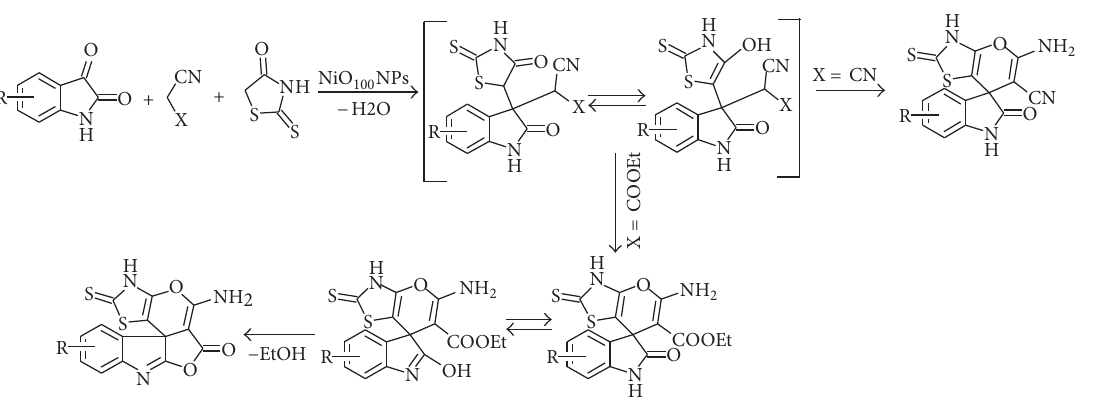
S 2: Plausible Mechanism for the reaction of 1H-indole-2,3-dione and malononitrile with